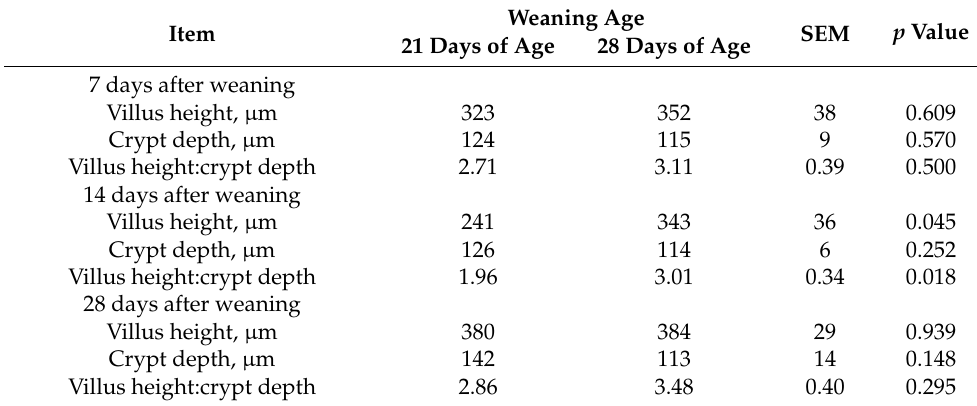
Table 6. Effect of weaning age on morphology of jejunum in weaned pigs 1 .